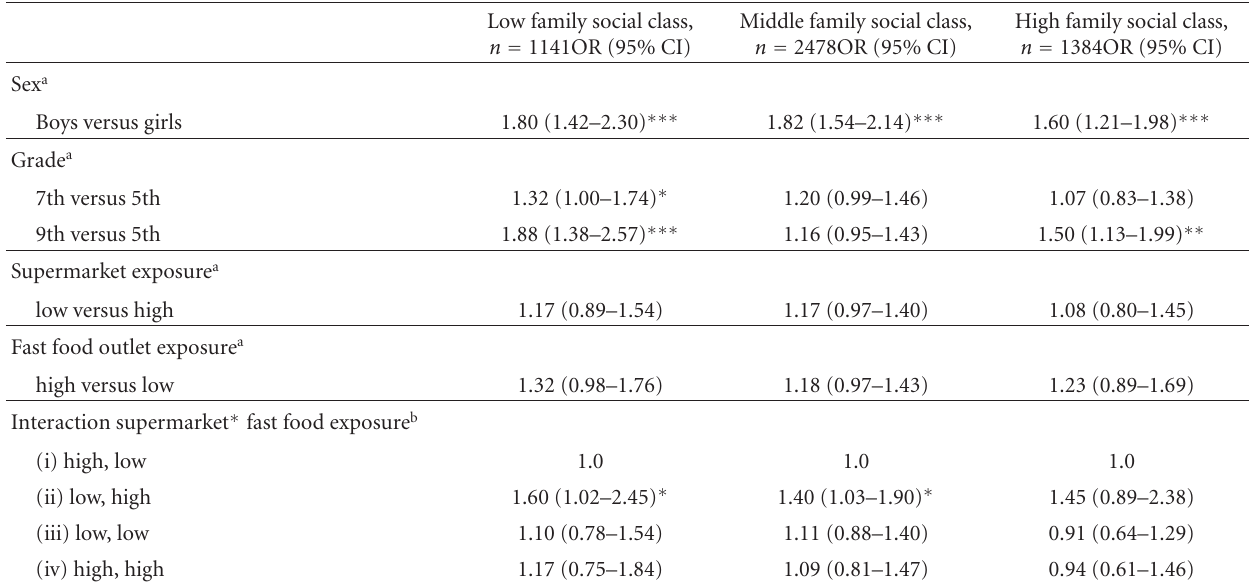
Table 2: Adjusted odds ratios (95% CI) for infrequent fruit consumption, separate analyses for students in low, middle, and high family social classes.